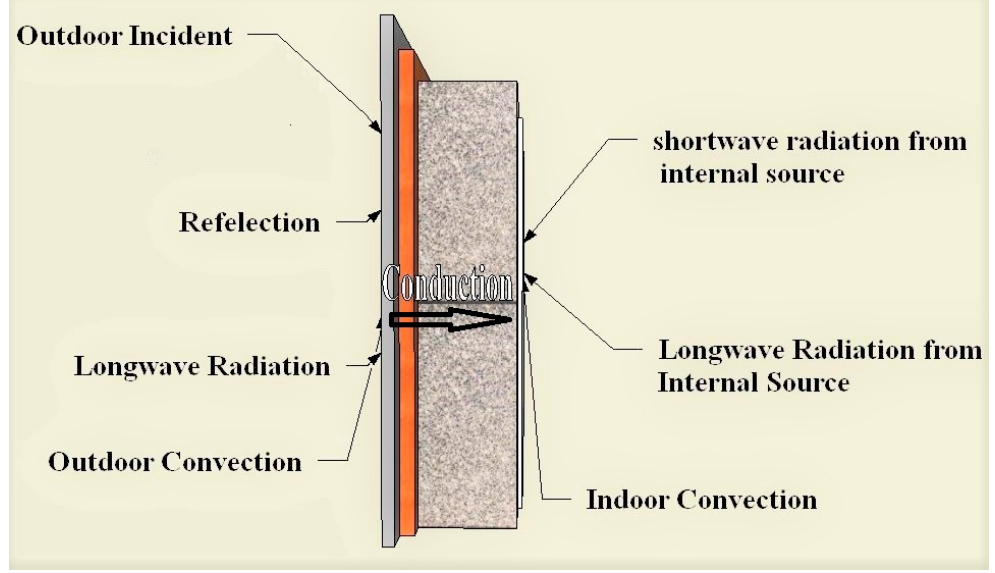
Figure 3. Inside and outside the energy balance control volume.